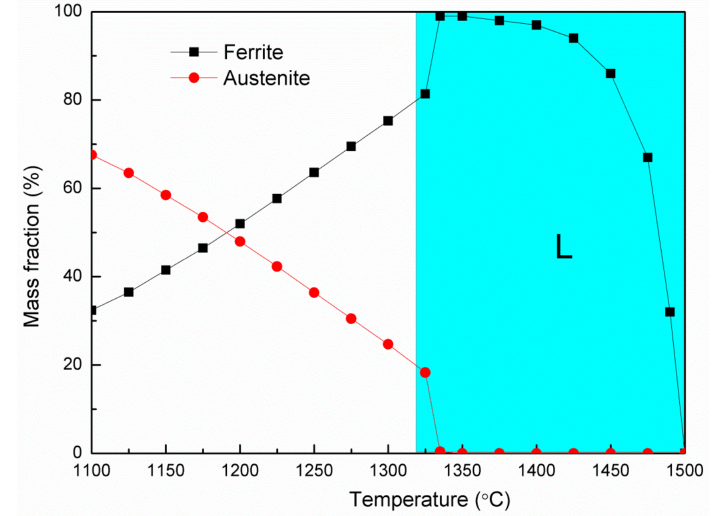
Figure 2. The phase composition of 13CrMoNbV steel at elevated temperatures according to thermodynamic